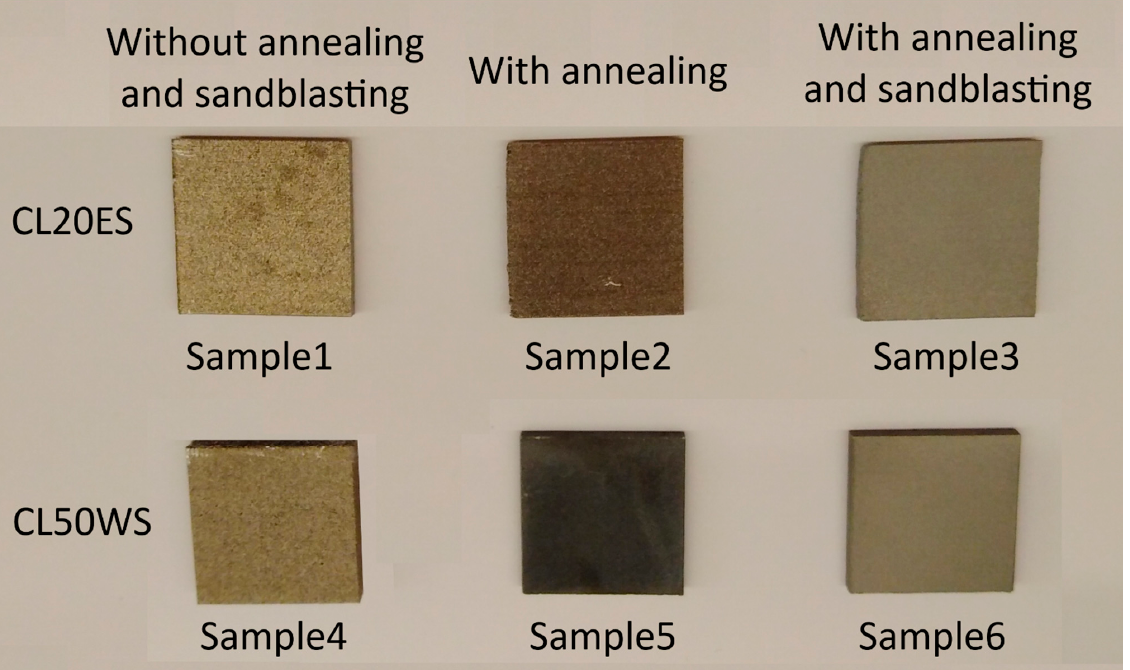
Figure 1. All six test samples ordered by the material they are made of and the treatment they